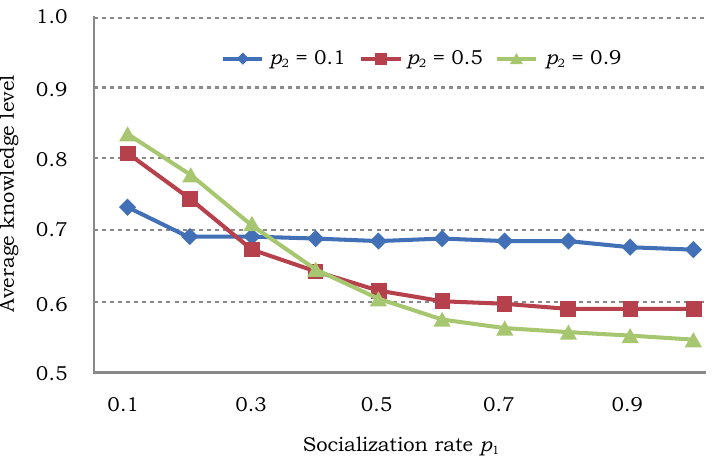
Figure A1. Average knowledge levels of Takahashi’s (1998) revised model Note: m  30, n  50, 80 periods, 100